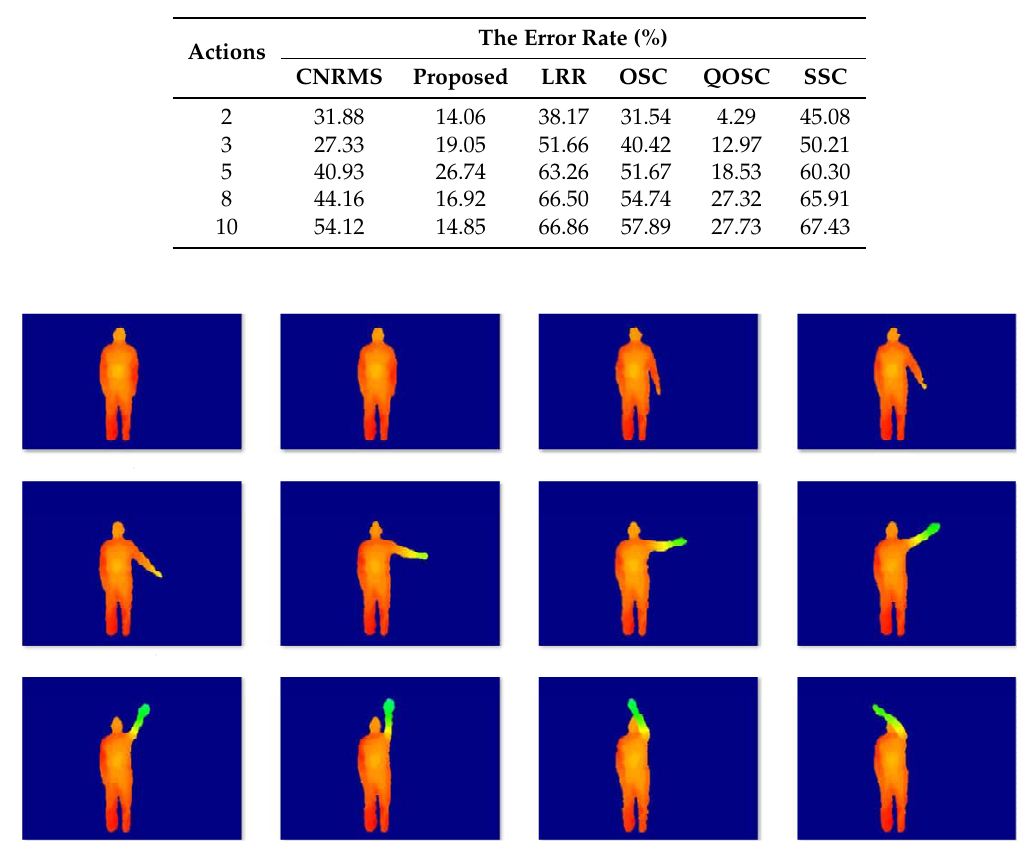
Table 3. 3D action clustering error (%) on the MSR Action3D dataset.